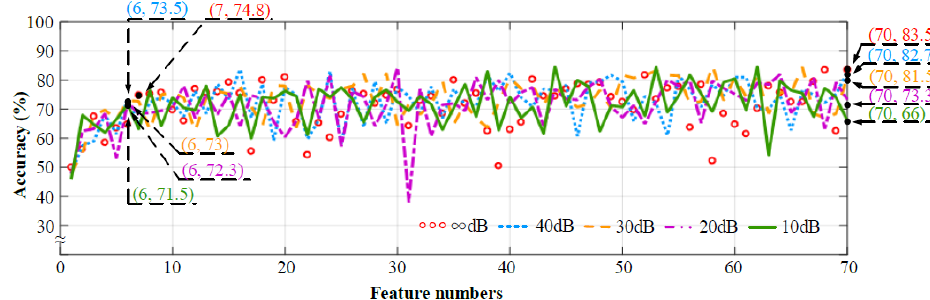
Figure 14. Accuracy curves of the MRA–CFFS.